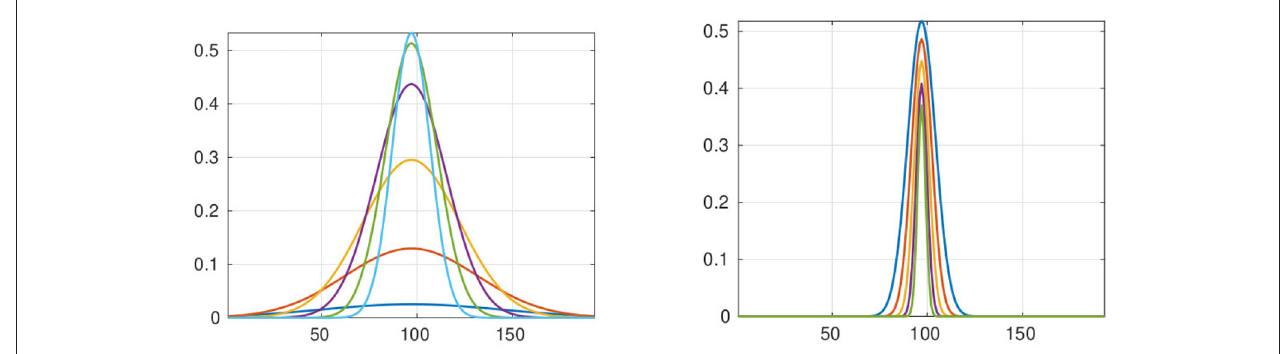
FIGURE 5 | Long-range ( left ) and short-range ( right , a base 10 logarithmic scale) canonical vectors for the Slater function with the grid size n R 24, R l 6, λ = = =